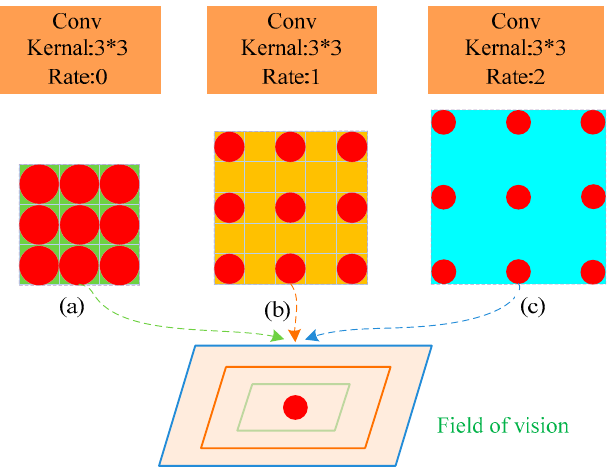
Figure 5. Expansion of the convolution kernel. ( a ) 3 × 3 convolution kernel at R = 0; ( b ) 3 × 3 convo- lution kernel at R = 1; ( c ) 3 × 3 convolution kernel at R = 2. convolution kernel at R = 1; ( c ) 3 × 3 convolution kernel at R =